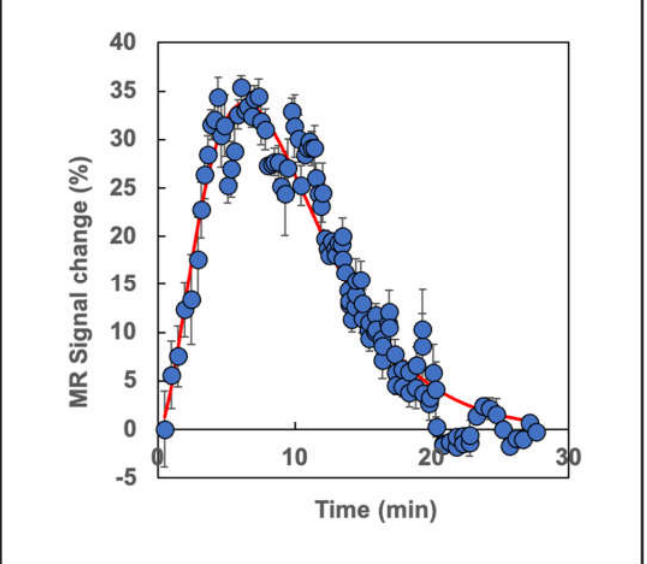
Figure 3. In vivo time course of gadolinium enhancement of the MR signal from the EF43. fgf4 breast tumors. The blue points are from four separate mice, while the red line is a non-linear fit to a gamma variate distribution using Mathematica (See Section 2) with A = 2.0, t o = 3.62 min, and t h2 = 3.18 min. The mean transit time for the gadolinium was 9.43 min and the gadolinium enhancement returned to pre-injection levels by 20 min. The peak occurred at 6.36 min after gadolinium injection. The MR sequence used was T 1 w RARE (T R = 1195 ms, T E = 11.55 ms). The errors are derived from the measured standard deviations of the noise levels in the MR images.